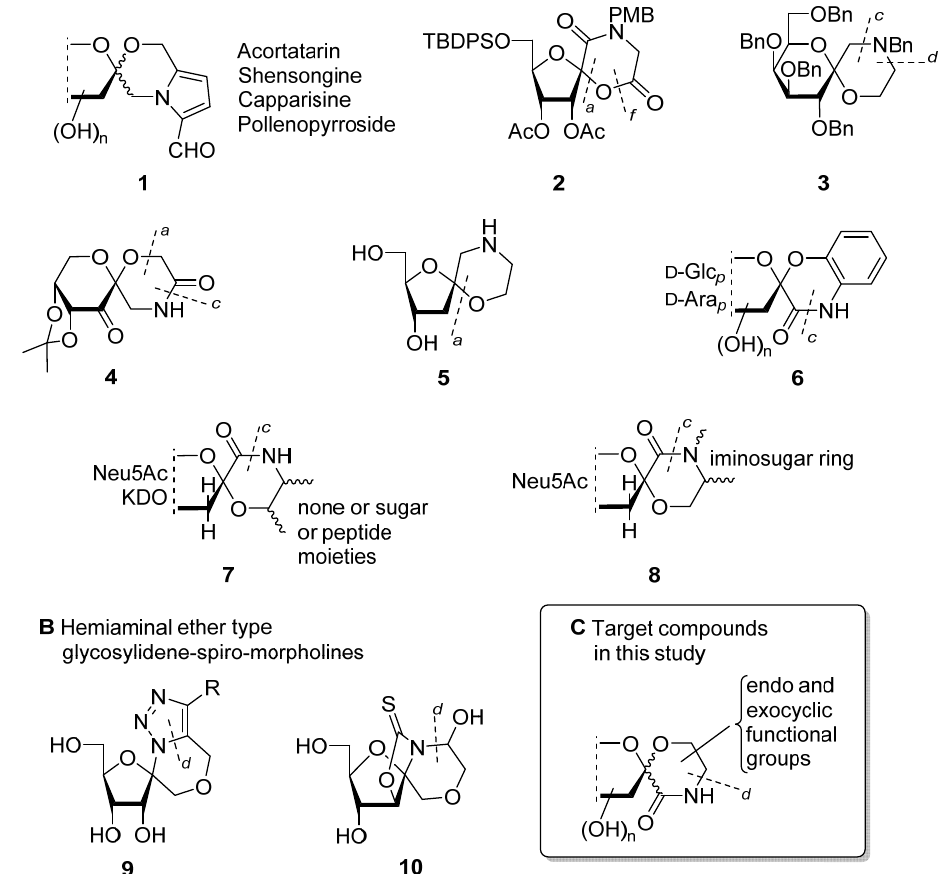
Chart 1. Glycosylidene-spiro-morpholines known from the literature ( A , B ), and target compounds of the present work ( C ). Dashed lines indicate ring closing bond formations used in the construction of the morpholin(on)e moieties (for detailed explanation, please, see text). Ring annulated derivatives, such as benzoxazinones [20,21] 6 and sialoconjugated spiro-morpholinones with no additional substituents [22] or with various sugar [23–27] or peptide [28] moieties ( 7 ) as well as iminosugars [29,30] ( 8 ) attached to the morpholine ring, were synthesized for diverse biological purposes.